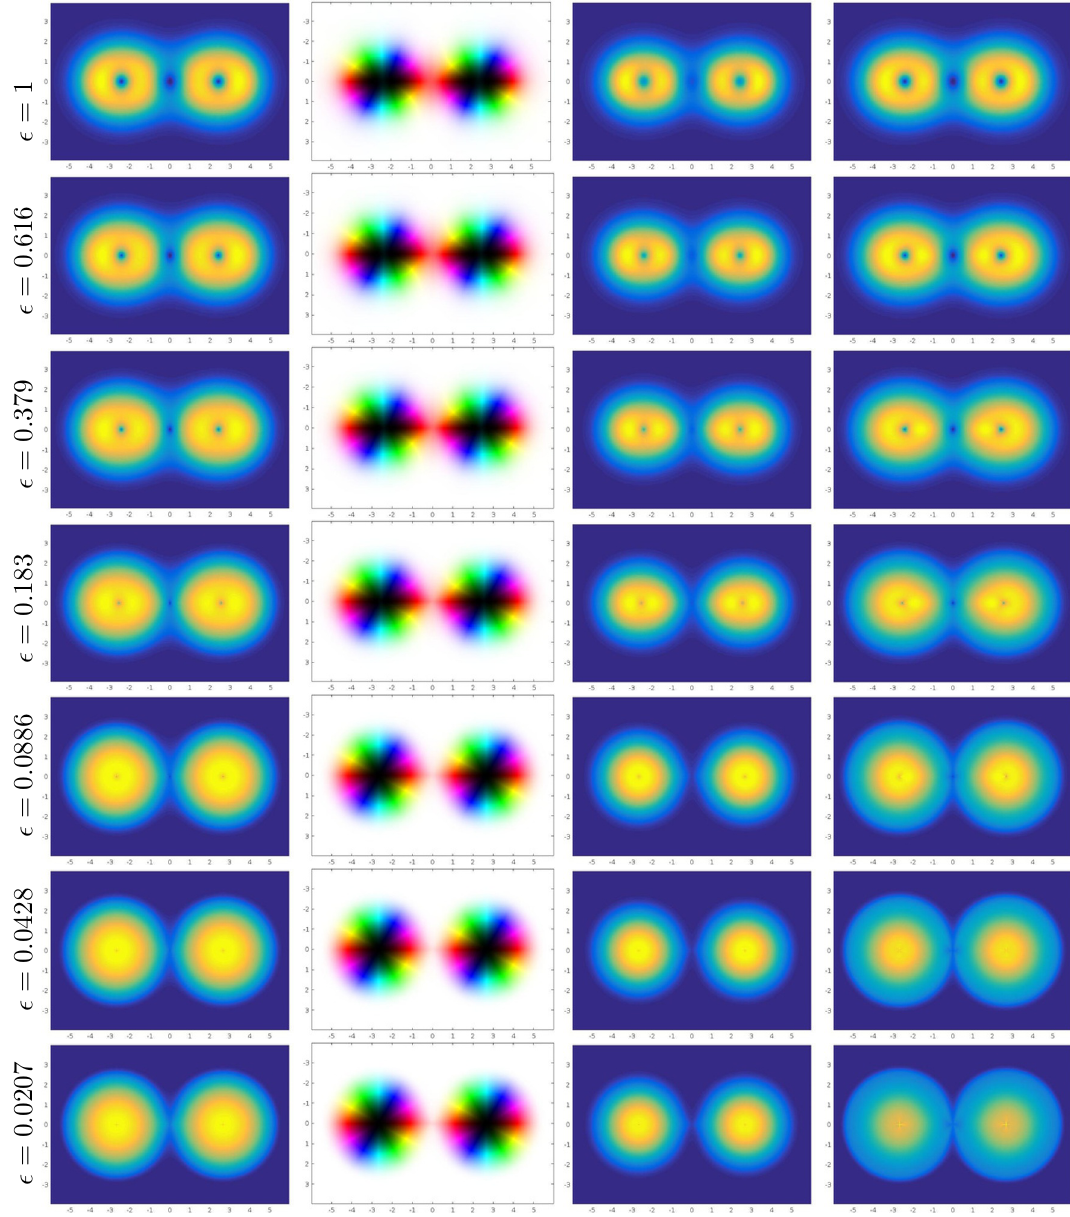
Figure 4 . The Q = 2 + 2 baby Skyrmion solution as a function of (cid:15) , which is the stable Q = 4 solution. The columns display the topological charge density, the field orientation using the color scheme described in the text, the total energy and finally the kinetic term − (cid:15) L 2 . We note that the two stretched N = 2 baby Skyrmions become almost perfectly round in the last row (for (cid:15) = 0 . 0207